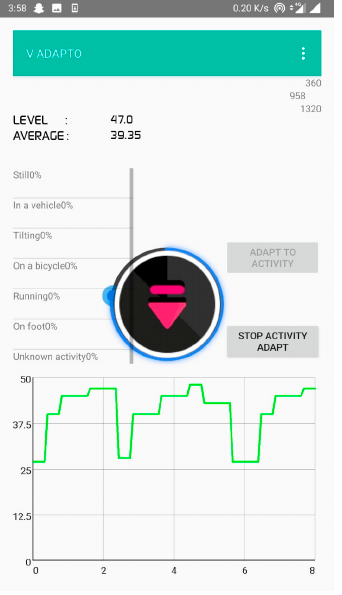
Figure 15. Average level below 40. Table 1. Comparison of the proposed system with existing systems.